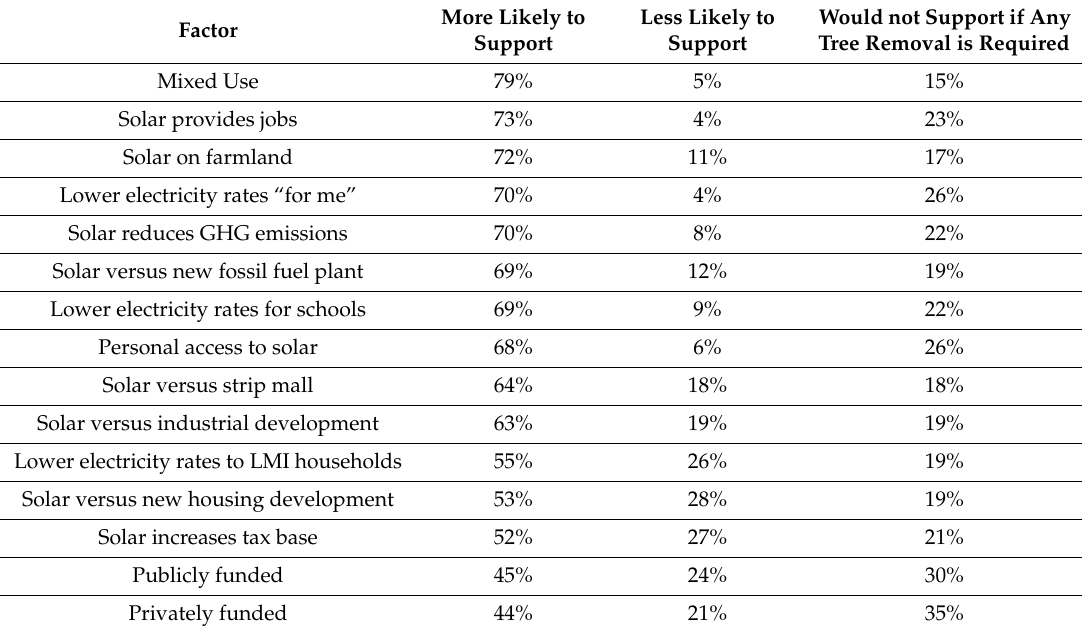
Table 2. Relative Support for Solar Given Various Development